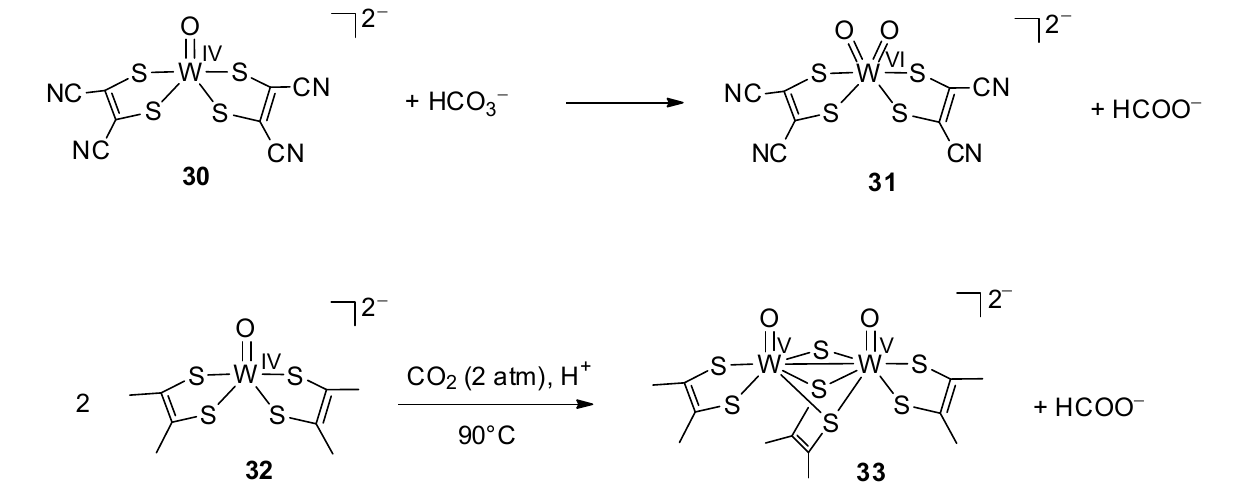
( d ) Figure 5. Structure representations of ( a ) [Co III Cp(qpdt)] 19 , ( b ) [Co III Cp(H ‐ qpdt)] 26 , and ( c ) [Co III Cp(2H ‐ qpdt)] 27 and ( d ) Mo IV (MPT) 2 3D ‐ simplified representation of an MPT ligand in FDHs. 4. Functional Models Until now, most dithiolene complexes studied for their catalytic activity have been tested for the reduction of protons into H 2 [40,44–51]. In the first part, we will focus on a few examples of tungsten or molybdenum ‐ bis(dithiolene) complexes that were shown to react with carbon dioxide. In the second part, we will discuss metal dithiolene complexes, with other metal ions than molybdenum or tungsten, which catalyze the reduction of CO 2 . Finally, we will also present those active complexes containing tungsten or molyb ‐ denum, but without sulfur ‐ based ligands. 4.1. Mo/W ‐ (dithiolene) 2